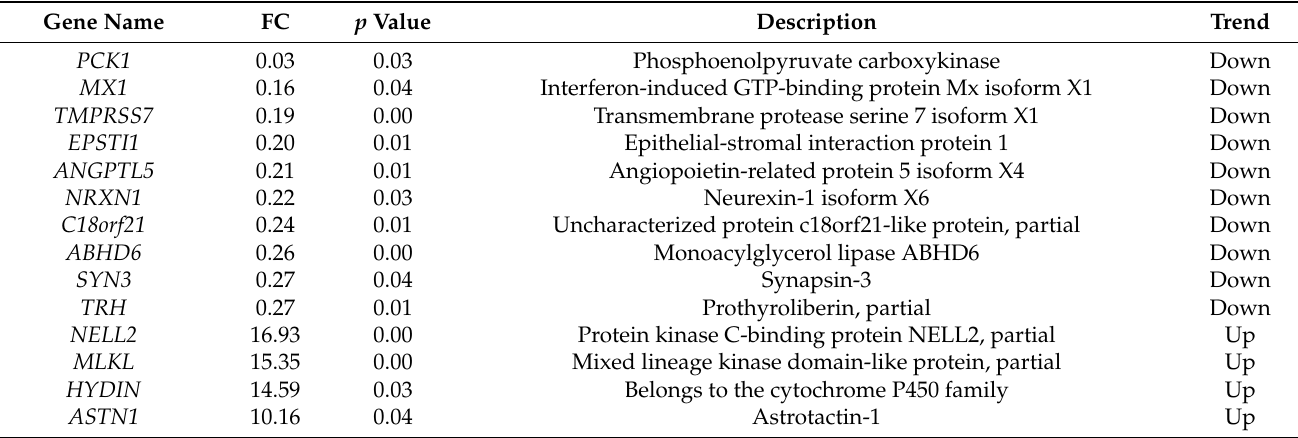
Table 2. The top 20 known differentially expressed genes between 35 wk and 12wk.